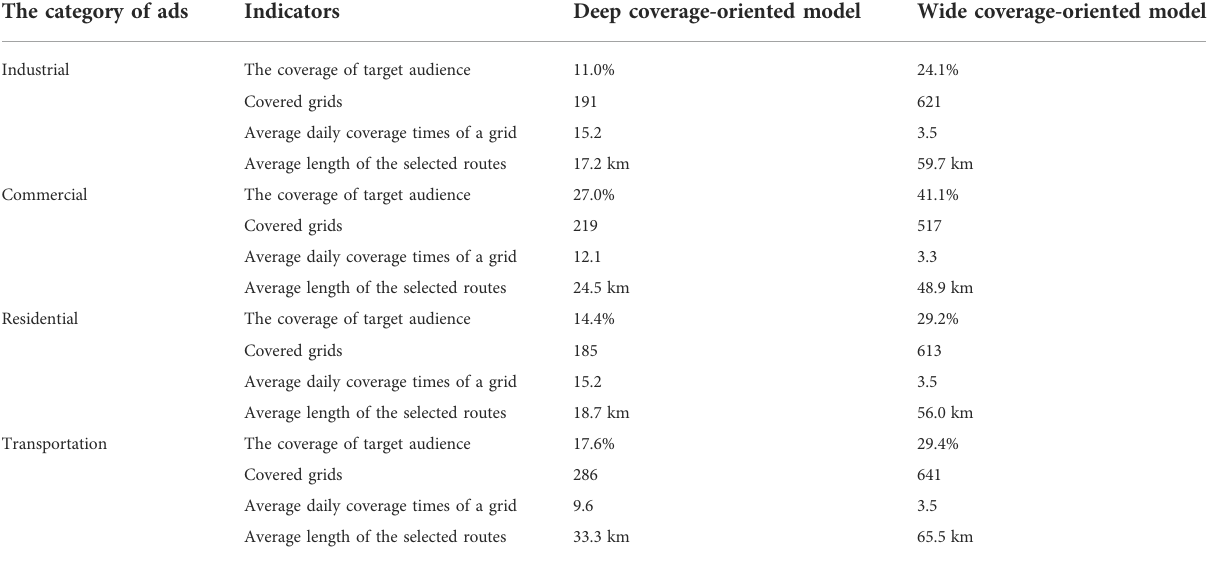
TABLE 3 Evaluation of the deep coverage-oriented